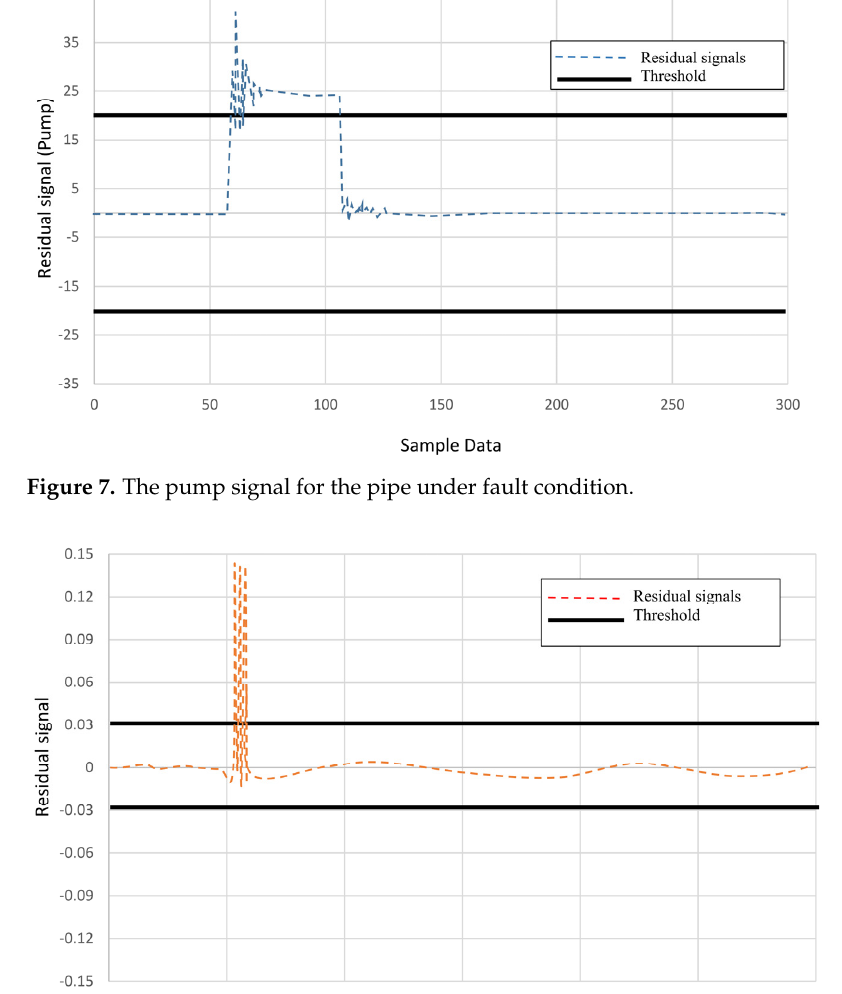
Figure 9. The effectiveness of the proposed technique for fault estimation under fault condition.